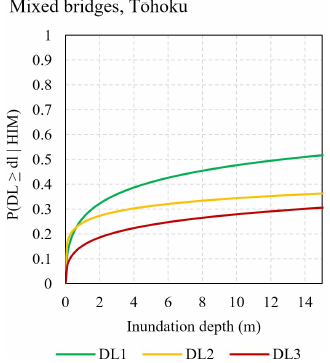
Figure 14. Fragility function for mixed-construction road bridges for the 2011 T ¯ ohoku earthquake and tsunami,